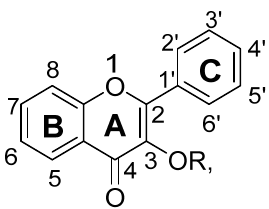
Figure 29. SAR of Flavonols. Figure 29. SAR of